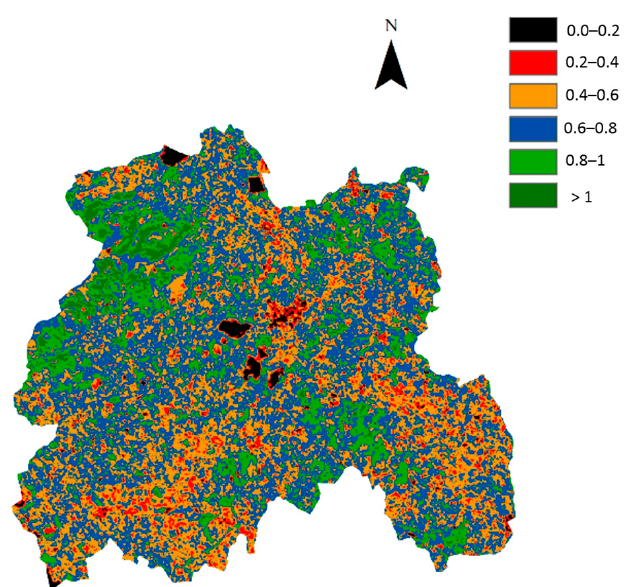
Figure 6. Modelled ET r F values (17 July 2006).